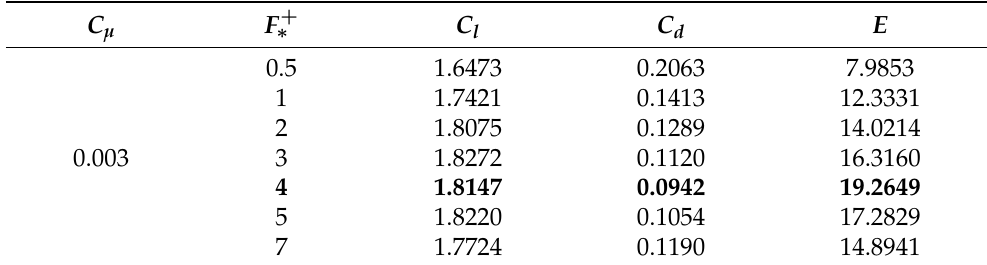
Table 3. Time averaged aerodynamic coefficients and efficiency obtained for the set of F + ∗